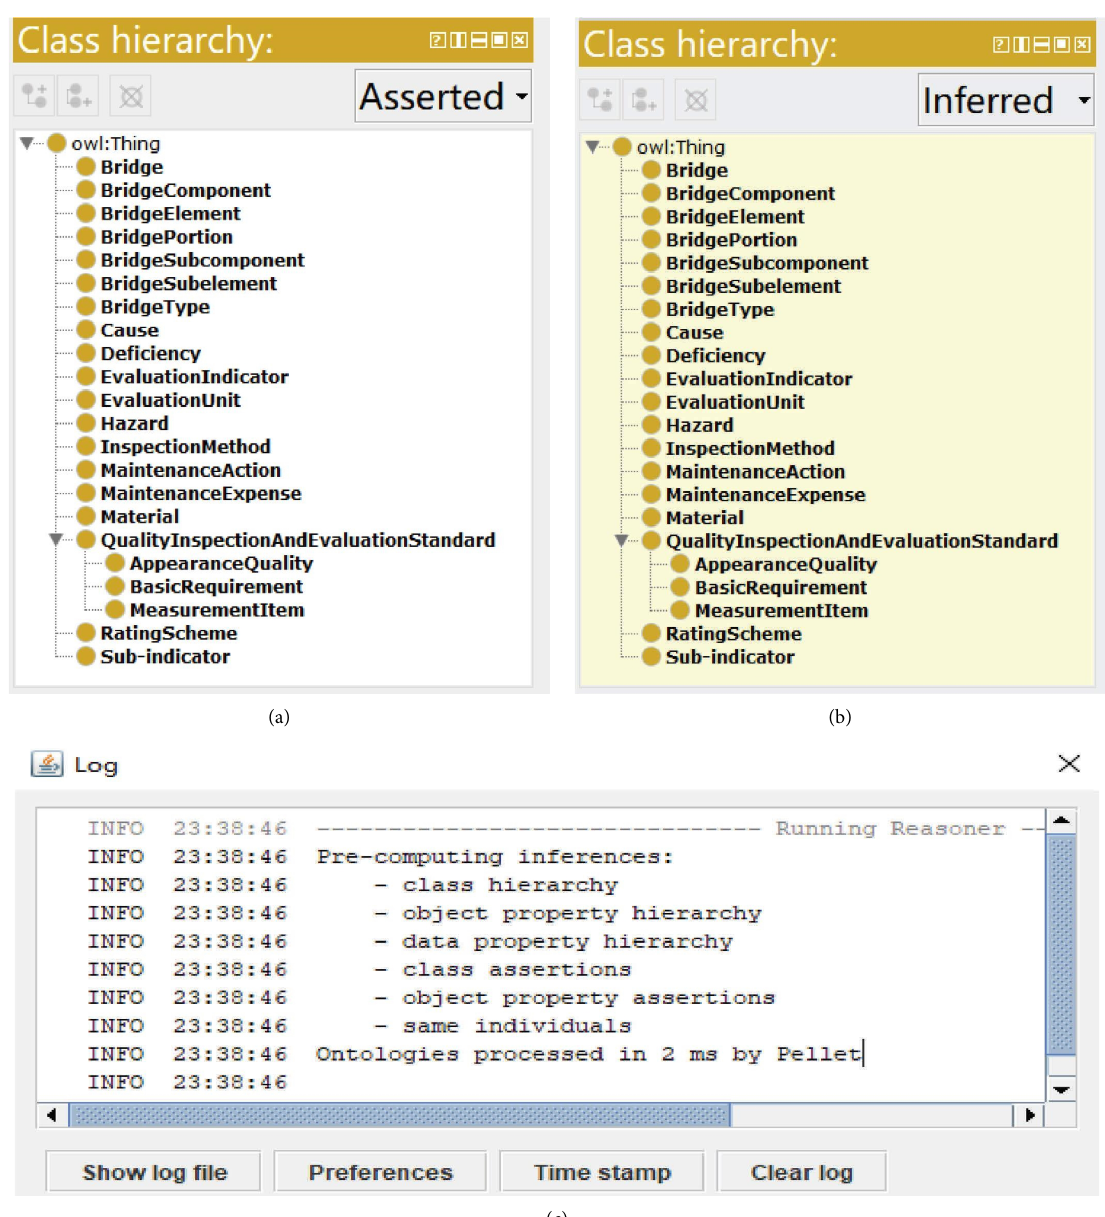
Figure 11: Te results of consistency check: (a) before the reasoning, (b) after the reasoning, and (c) the reasoning